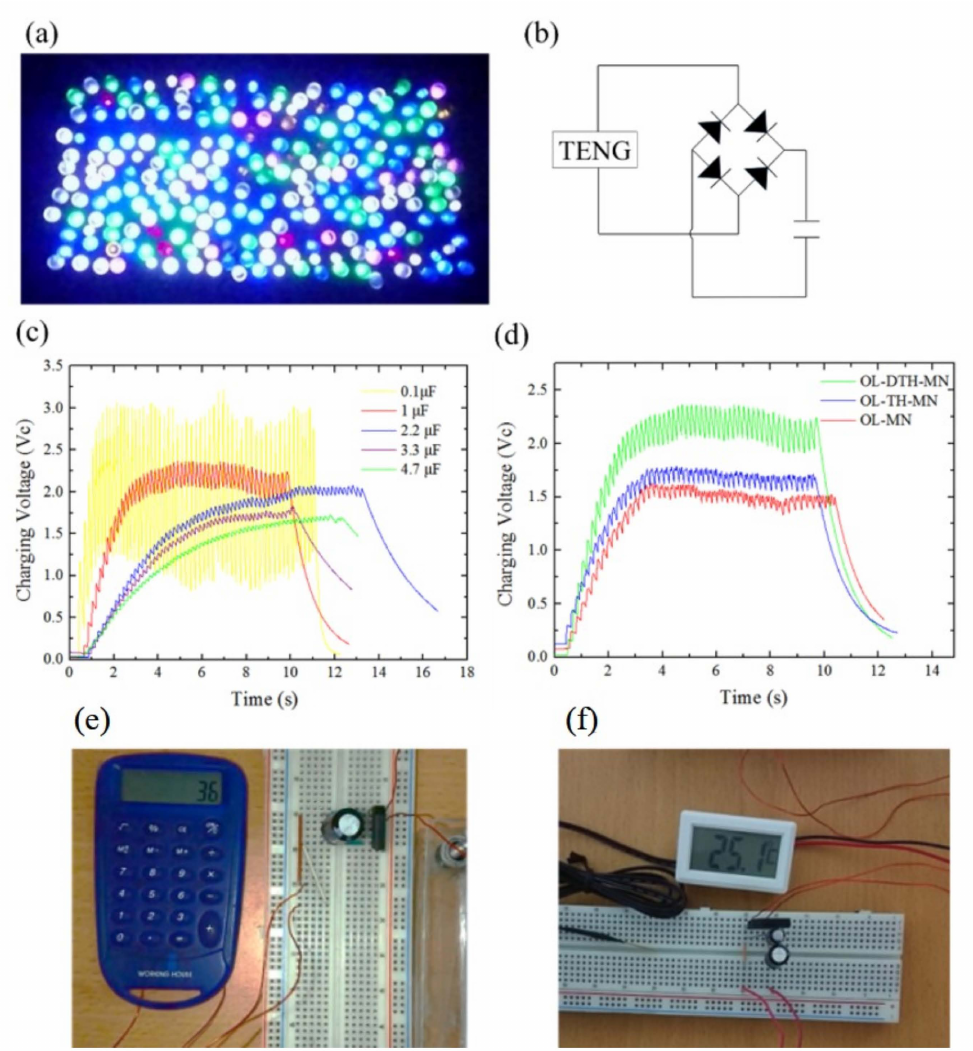
Figure 33. Lighting and energy storage: ( a ) OL-DTH-MN–TENG driving 226 LEDs of six different colors contacted in series, ( b ) circuit design for charging, ( c ) charging voltage of OL-DTH-MN-TENG from 0.1 µ F to 4.7 µ F capacitor, ( d ) the charging voltage curve on a 1 µ F capacitor of OL-MN- TENG, OL-TH-MN-TENG, and OL-DTH-MN-TENG; ( e ) the direct drive of the calculator, ( f ) the self-powered temperature